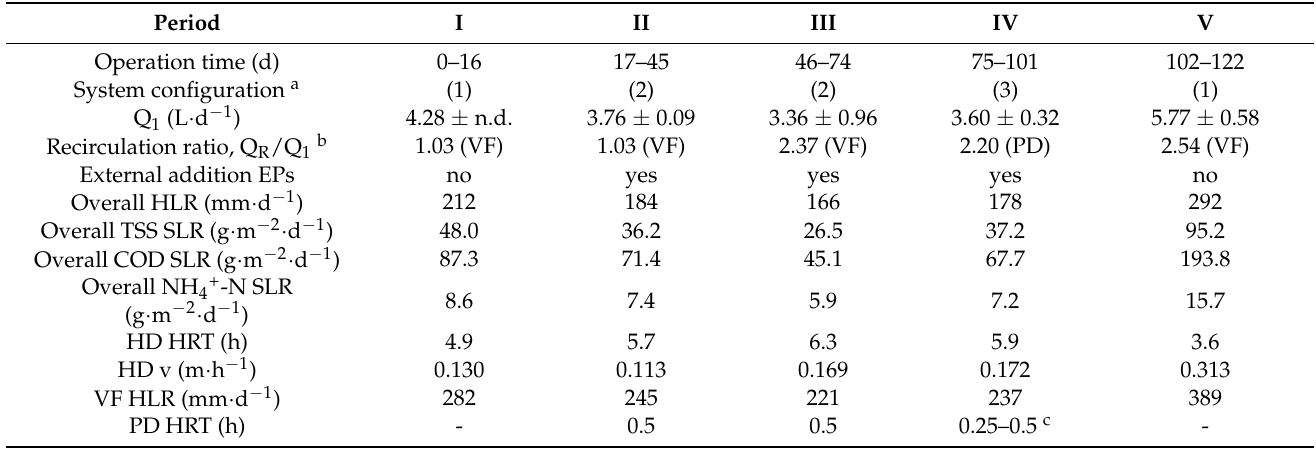
Table 1. Operational characteristics of the combined HD–VF–PD